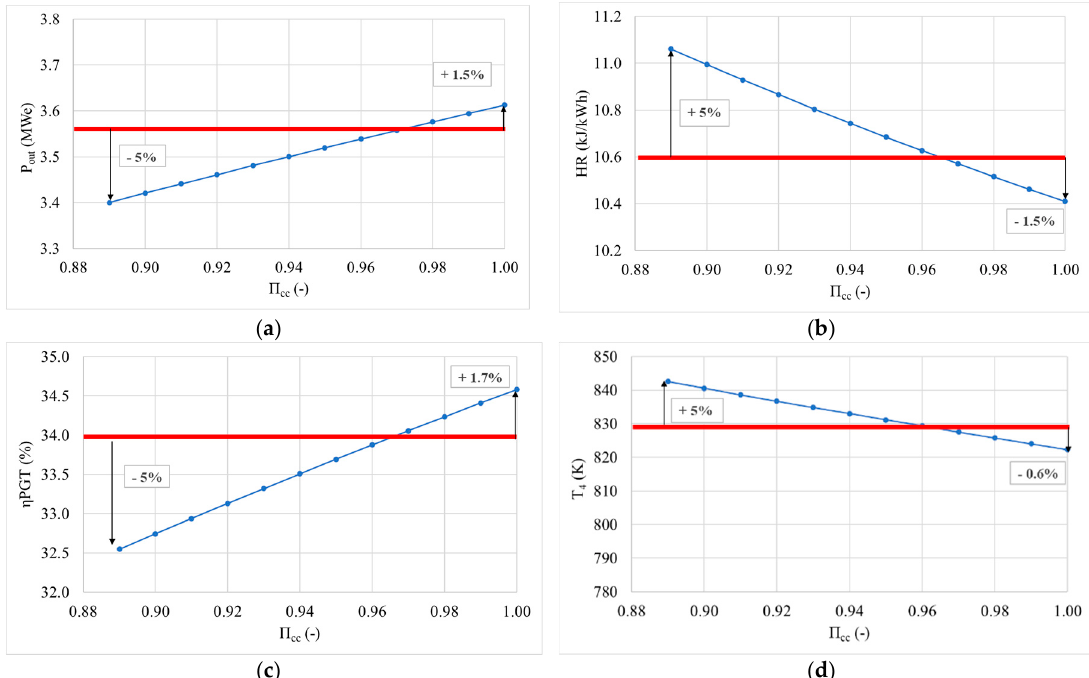
Figure 8. Change of gas turbine cycle outlet parameters in function of combustion chamber pressure ratio ( a ) power change in function of combustion chamber pressure ratio, ( b ) heat rate change in function of combustion chamber pressure ratio, ( c ) gas turbine plant efficiency change in function of combustion chamber pressure ratio and ( d ) change of temperature of the expanded products at the gas turbine outlet in function of combustion chamber pressure ratio.